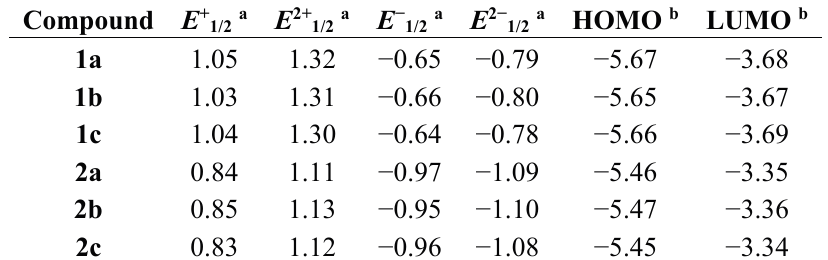
Table 3. Summary of half-wave redox potentials, HOMO and LUMO energy levels for 1a – 1c and 2a – 2c .